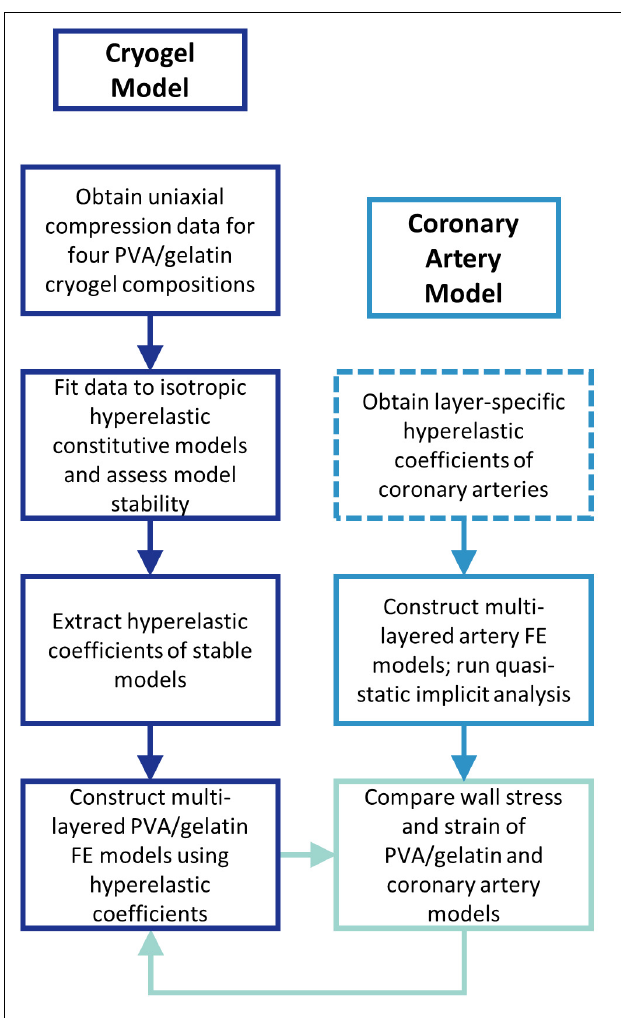
FIGURE 1 | Flow chart outlining the study methodology. Dashed lines represent the steps performed outside of the study.